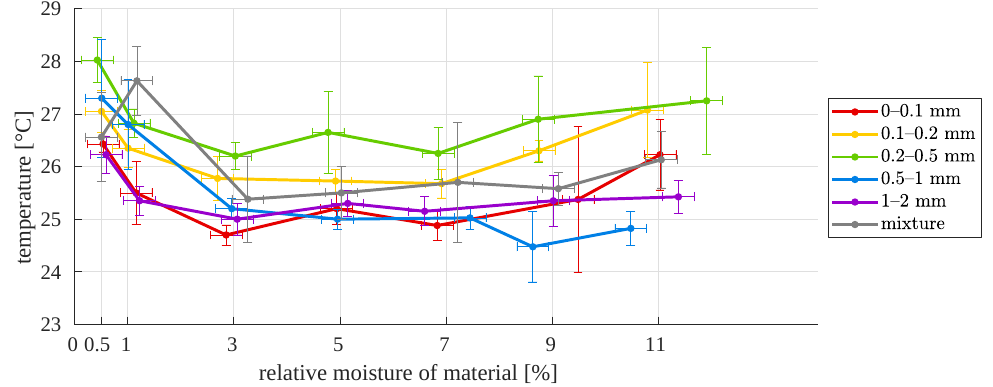
Figure 14. Surface temperature as function of particle size, for different relative moistures; first approach (macro images).